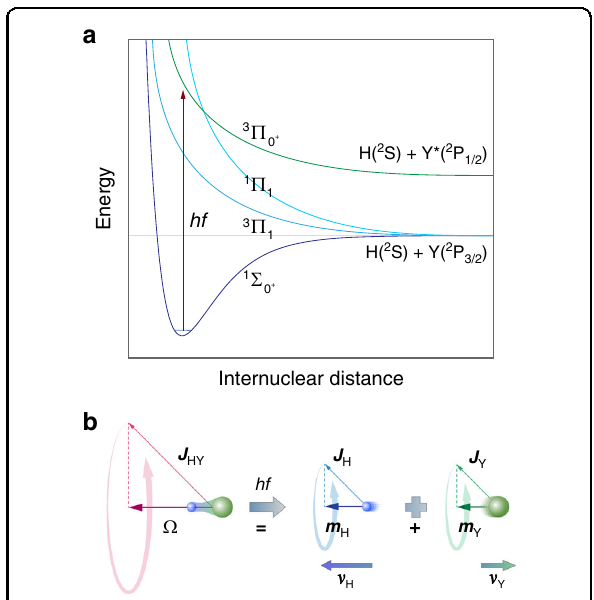
Fig. 1 Correlation of molecular electronic states to atomic m states. a The potential energy curves that participate in the photodissociation HY. b The total electronic angular momentum projection ( Ω ) of HY is conserved during the dissociation and is equal to the sum of the product m states: Ω = m A + m